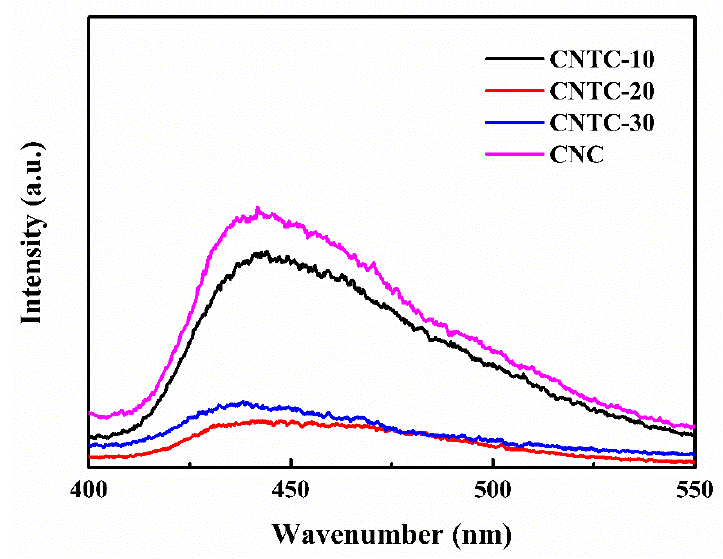
Figure 4. Photoluminescence spectra of CNTC and